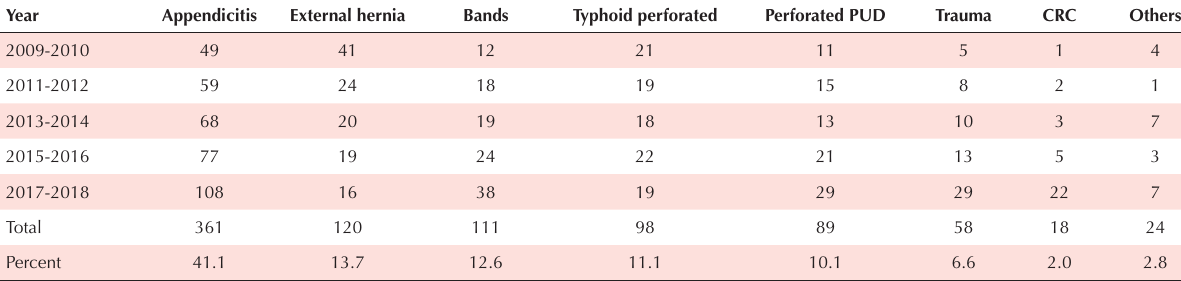
Table 2. Annual laparotomy rates for the various indications